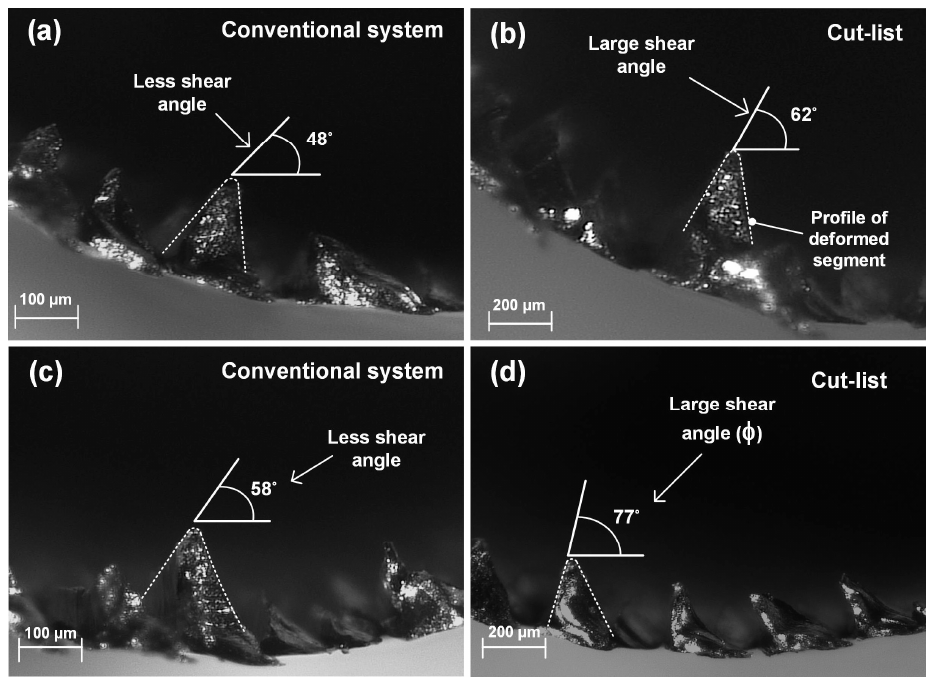
Figure 22. Shear angle ( φ ) observed at cutting speeds of ( a , b ) 95 m/min and ( c , d ) 200